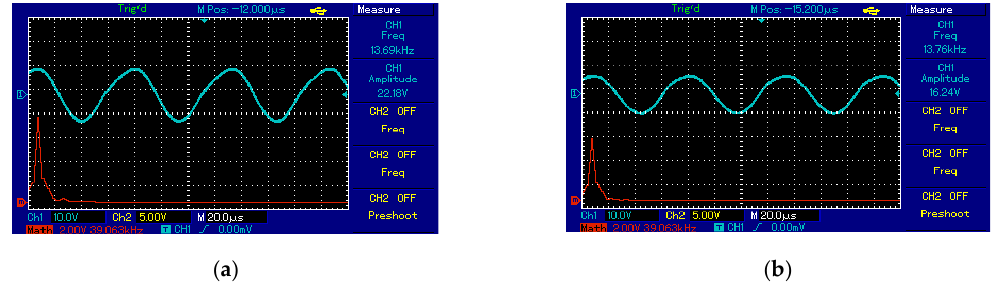
Figure 15. The voltage waveforms using third topology at 7 cm for: ( a ) transmitter coil and ( b ) receiver coil.